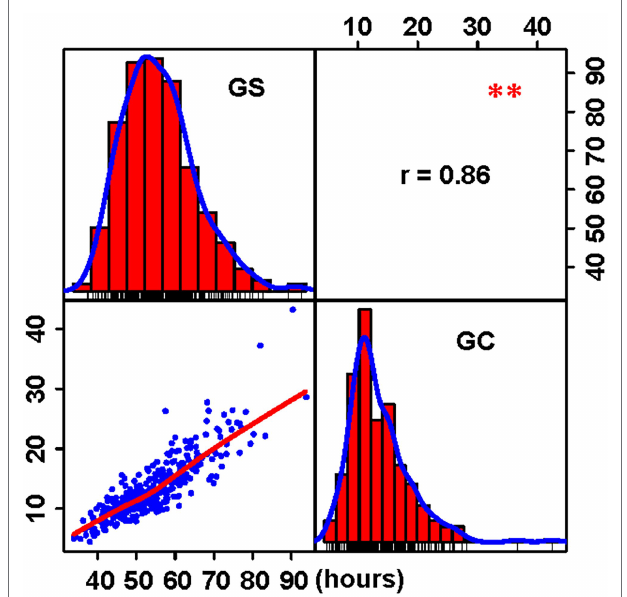
FIGURE 1 | Frequency distributions and correlations of two germination traits. The plots on the diagonal show the phenotypic distribution of two traits. The plots below the diagonal line are the scatter plots compared with two traits, and the values above the diagonal line are Pearson correlation coefficient between traits. ** p ≤ 0.01; GS represents the germination speed; and GC represents the germination consistence.